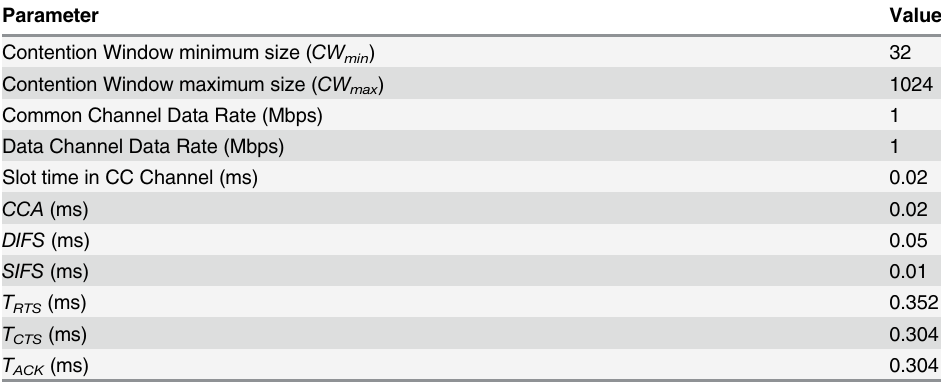
Table 1. Evaluation parameters